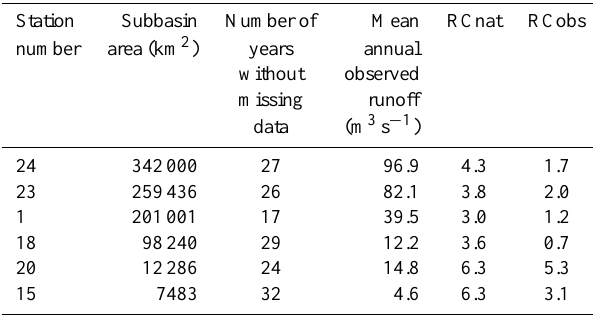
Table 2. Naturalized runoff coefficient (RCnat) and observed runoff coefficient (RCobs) for selected